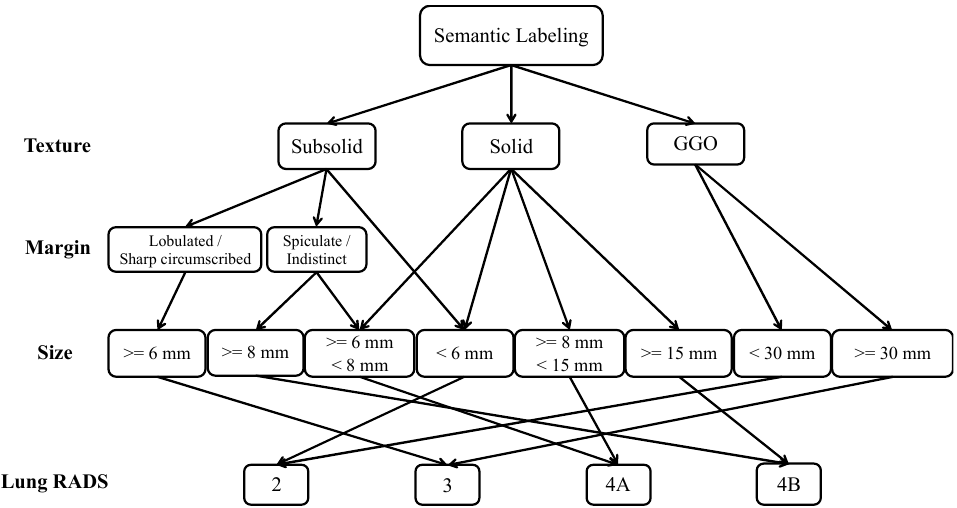
Figure 2. The decision process of the Lung-RADS model. The criterion for determining Lung-RADS at the first (top) level is the type of texture, including Subsolid, Solid, and GGO. Then, if the Texture is Subsolid, the category of margin is further categorized into Lobulated/Sharp Circumscribed, or Spiculate/Indistinct. The last criterion is the size, which denotes how big the tumor is, and the final definition of Lung-RADS categories depends on the size of the tumor.